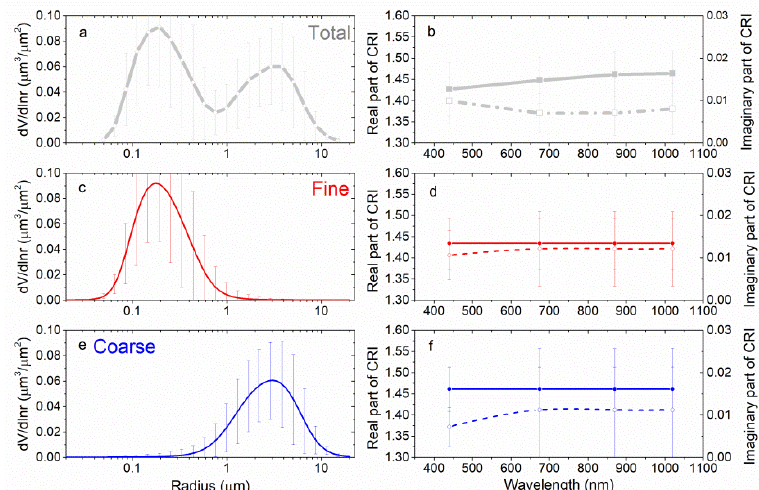
Figure 4. The separated volume size distribution and sub-mode complex refractive index of multi-year average. The data source of ( a ) and ( b ) for total modes are from the inversion algorithm of SONET, and others ( c – f ) are from the sub-mode algorithms. ( a ) Total volume size distribution ( b ) Total complex refractive index in four wavelengths; ( c ) Fine-mode volume size distribution; ( d ) Fine-mode complex refractive index; ( e ) Coarse-mode volume size distribution; ( f ) Coarse-mode complex refractive index; The solid lines in figure ( b ), ( d ), ( f ) are the real parts of complex refractive index, and the dash lines are the imaginary parts. The corresponding parameters are listed in Table 2.